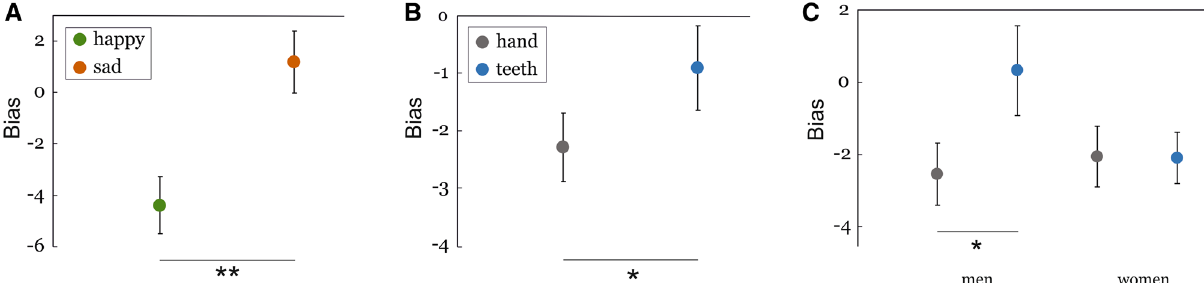
Figure 3. Emotional bias in the working memory task. ( A ) Effect of emotion. Happy faces (green) were remembered as being less happy (i.e., more negative) for sad faces this negative bias was less pronounced. ( B ) Effect of FFM. Independent of the emotion, emotional faces were remembered as being more positive/less negative during teeth (blue) than during the hand (grey) condition. ( C ) Emotional bias for male (left side) and female (right side) participants for the hand (grey) and teeth (blue) FFM condition. Men remembered faces more positive during the teeth compared to the hand condition than did women. Error bars represent standard errors (SE). * p < .05, ** p ≤